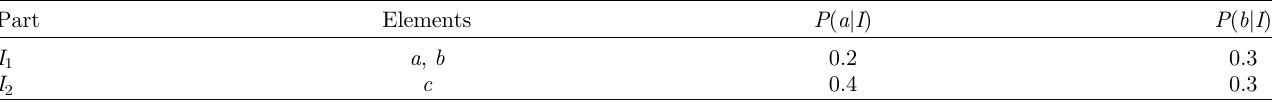
Table 4. Partition I and transition probability of each part I i , i = 1, 2 to each element in the alphabet A . Part